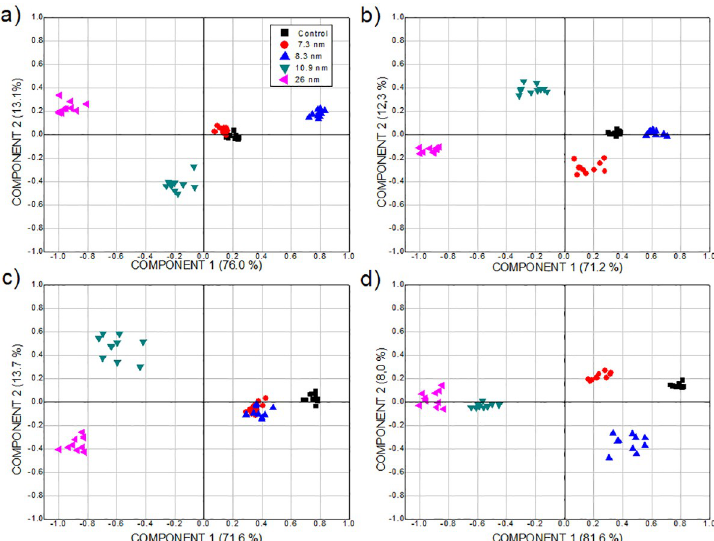
Fig 8. Plots of PCA scores considering the ROE of plants treated with Ag-TiO 2 NPs. NPs of size 0 (control group), 7.3, 8.3, 10.9 and 26 nm, applying a) 0.25, b) 2, c) 4 and d) 6%